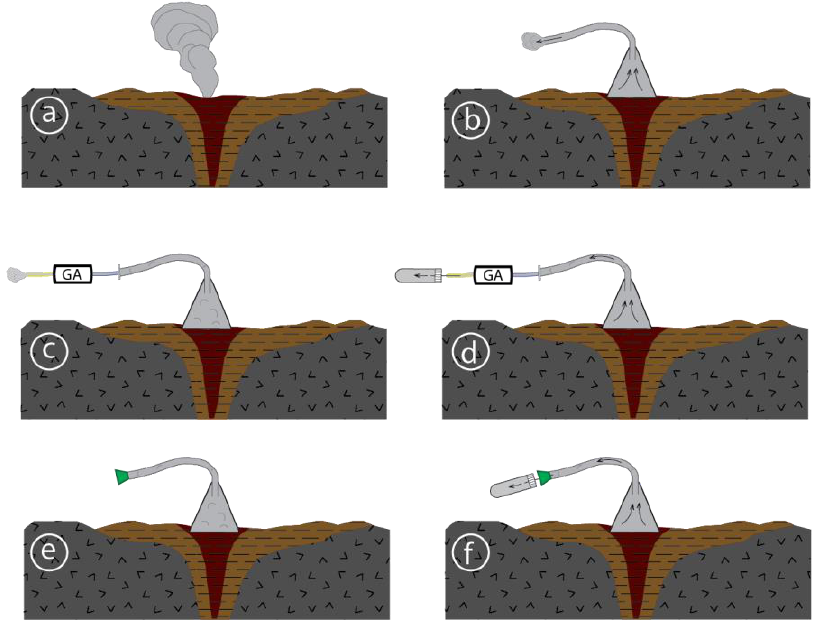
Figure 7. Gas measurement and sampling setup. ( a ) Fumarole system; ( b ) flushing step, with a silicone funnel on the fumarole; ( c ) measurement step, with the measurement tool connected to the collection device and the pump started; ( d ) sampling step, with the needle inserted at the outlet of the measuring tool and the gas collected in vials; ( e ) sampling without the pump, after the flushing step, with the septum at the end of the silicone pipe; ( f ) needle inserted into the septum and gas collected in vials. When gas concentrations increased significantly (typically after 20–30 s, depending on the flow rate), a double-inlet needle (Fischer; 10505444; Greiner Bio-One 450076; 3.81 cm; 21 g; stainless steel) was used to connect the outlet tubing of the analyzer to a glass vial under vacuum to collect the gas (Figure 7d). The vial was allowed to collect gas for approximately 1 min. Two more vials were then used to collect triplicates, one of which was 20 or 12 mL and the other of which was 5.9 mL. The Labco Exetainer ® -type vials, sealed and under vac- uum, were equipped with a butyl septum to make them impermeable to H 2 . This device provided some indication of gas concentrations, via the analyzer, during sampling. Instead of putting the whole assembly in place when the flow was sufficient, a septum plug was placed at the outlet of the funnel or first casing once the air was expelled (Figure 7e). When the accumulation of gas in the funnel was deemed to be sufficient, based on vis- ible inflation of the bag, the septum plug was pierced with a double needle before attaching a sample vial (Figure 7f). Again, this sampling procedure continued for approximately 1 min or more, depending on the flow rate. 2.1.2. Field Gas Analysis Geotech’s BIOGAS 5000 is designed for in situ gas analysis. This analyzer, equipped with a pump, was used to measure the gas composition of the soils. In this instance, the gases measured were methane (CH 4 , %), carbon dioxide (CO 2 , %), oxygen (O 2 , %), hydrogen (H 2 , ppm), carbon monoxide (CO, ppm), and hydrogen sulfide (H 2 S, ppm); and finally, the balance was measured in % corresponding to the remaining non-analyzed gases. These measurements are non-destructive: the gas simply circulates through cells in the apparatus before being expelled. Between each measurement, the apparatus was purged to fully evac- uate the gas measured previously. CH 4 and CO 2 are analyzed in the tool using a dual-wavelength infrared sensor with a reference channel. This sensor determined the absorption of infrared light by the gas present in the tool. The gas molecules considered absorb light at different frequencies. Thus,